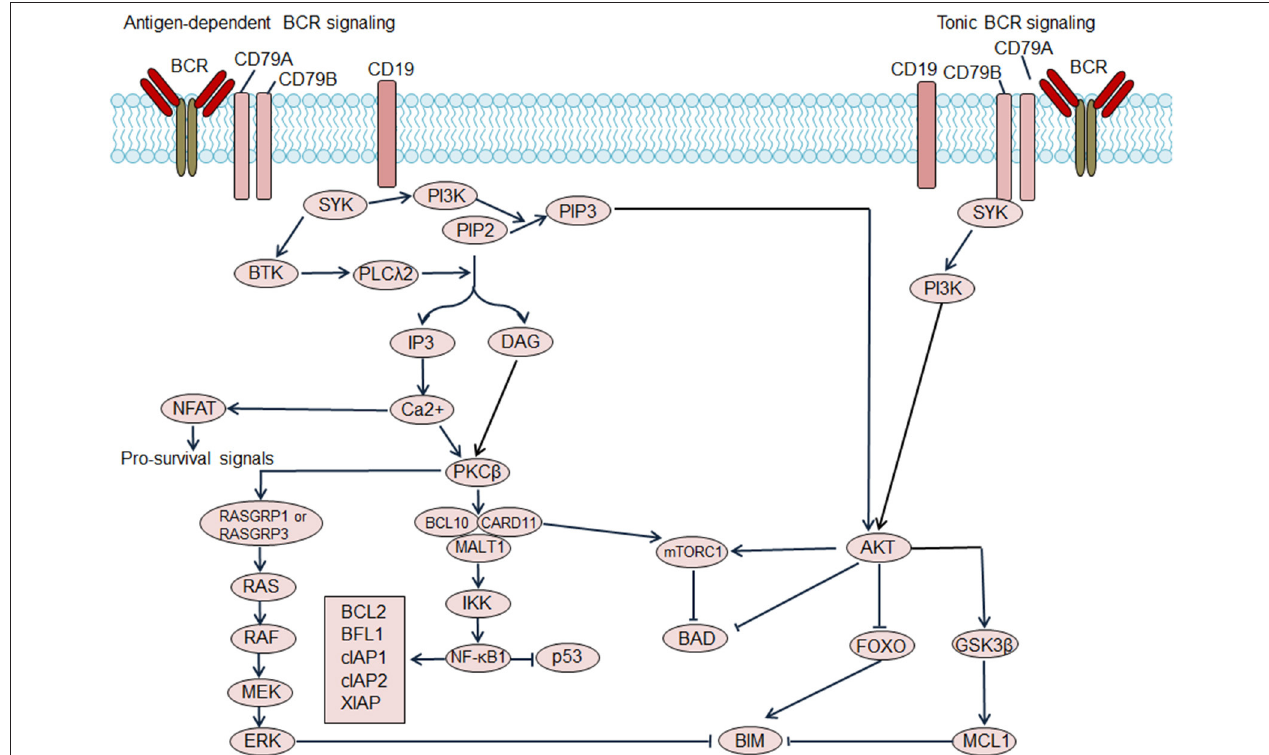
FIGURE 1 | Regulation of B cell receptor (BCR) signaling on B cell survival. Antigen dependent BCR signaling engages several downstream pathways, which include the NF- κ B pathway, PI3K/AKT/mTOR pathway, NFAT pathway, and MAPK/ERK pathway. NF- κ B activation promotes transcription of the pro-survival genes including BCL2, BFL1, cellular inhibitor of apoptosis protein (cIAP) 1, cIAP2, X-linked inhibitor of apoptosis protein (XIAP) and so on. Additionally, NF- κ B antagonizes the function of p53, thereby decreasing p53-mediated cell apoptosis. Activated AKT phosphorylates forkhead box class O family member transcription factors